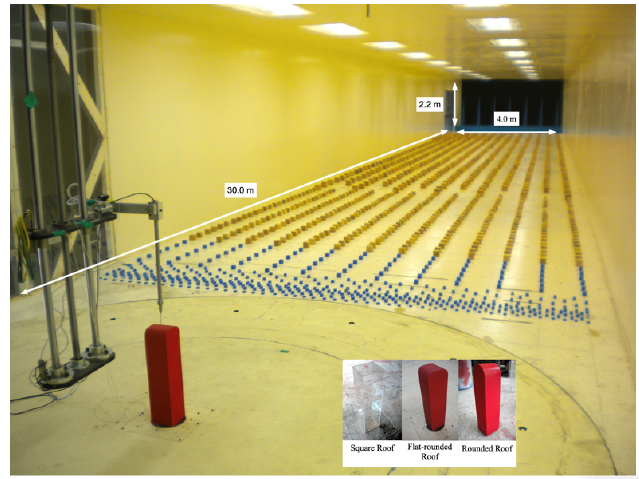
Figure 2. Building shape models (square roof, rounded corner roof, rounded roof) in CKP wind solution’s atmospheric boundary layer wind tunnel.